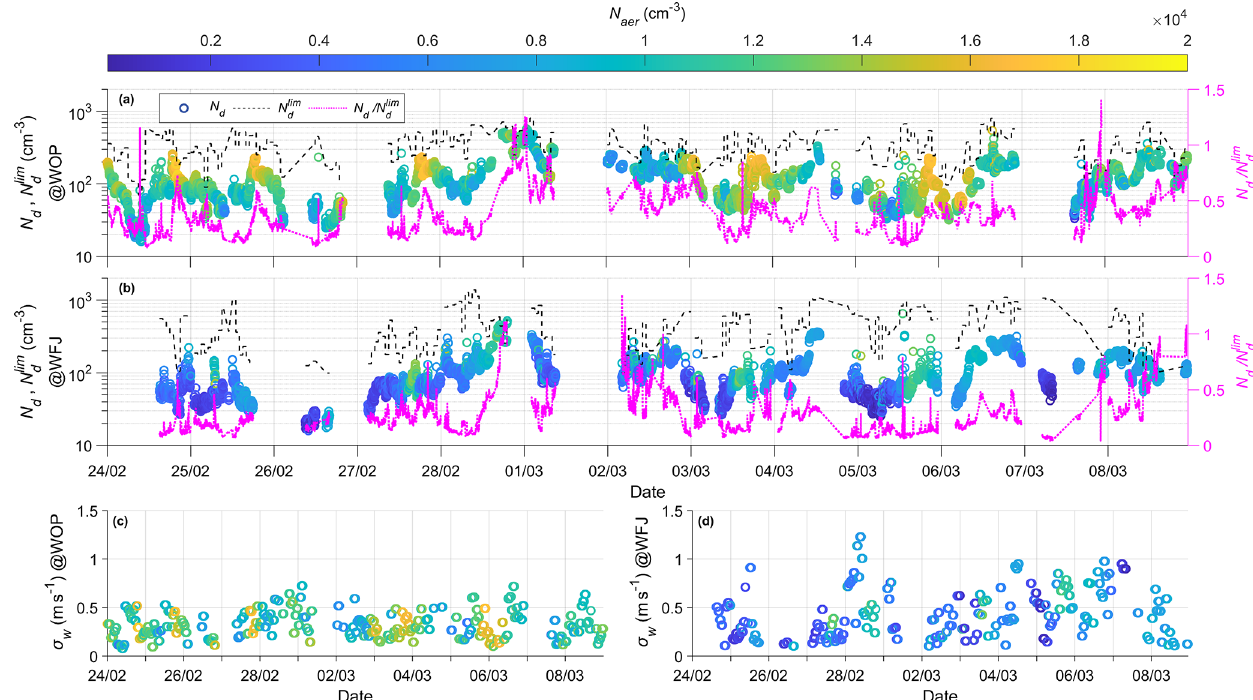
Figure 10. Time series of potential N d (cm − 3 ) (circles colored by N aer ) along with N lim those two (i.e., N d /N lim ) (magenta dotted line) together with the time series of the calculated σ w (ms − 1 ) (circles colored by N aer ), as d estimated for WOP (a, c) and WFJ (b, d)